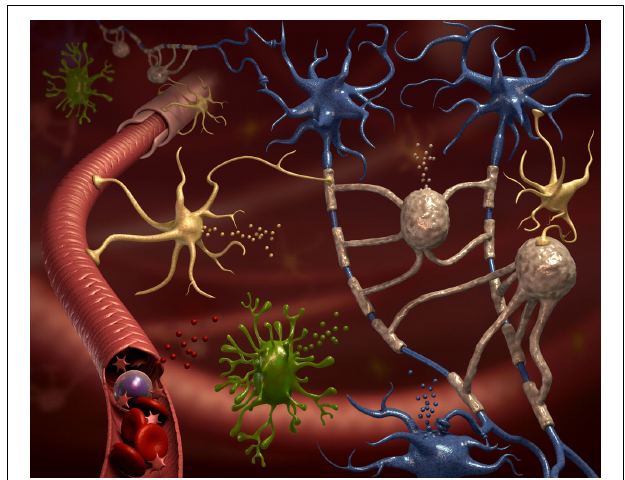
FIGURE 1 |All neural cell types release microvesicles (MVs). The CNS parenchyma is very complex in terms of cellular composition.This cartoon depicts neurons (blue cells), their axons surrounded by myelin produced by oligodendrocytes (gray cells), ramified microglia (green cells), astrocytes (yellow cells), and blood vessels (in red). Still, this is a very simplified representation of CNS tissue. All represented, and not represented, cell types are able to release MVs delivering signals to neighboring cells and into the environment (van derVos et al., 2011). Some of these MVs are drained to accessible biological fluids like the blood or the cerebrospinal fluid, where they might constitute a new class of biomarkers.